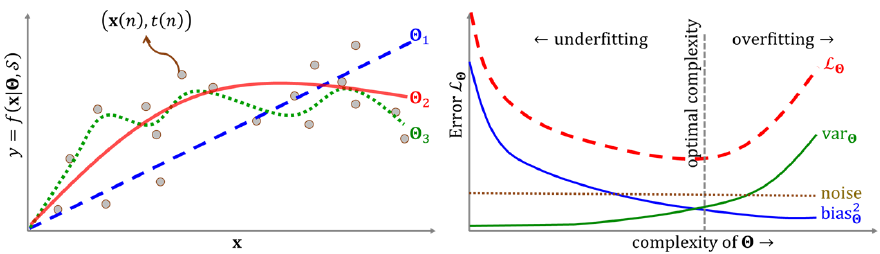
Figure 2. Bias, Variance, and Model Complexity. ( Left ) Performance of three models, Θ 1 (dashed blue), Θ 2 (solid red), and Θ 3 (dotted green) with low, optimum, and high model complexities. Small grey circles are training samples ( x , t ) ∈ S . ( Right ) Squared bias (solid blue), variance (solid green), noise (dotted brown), and loss (dashed red) as functions of model